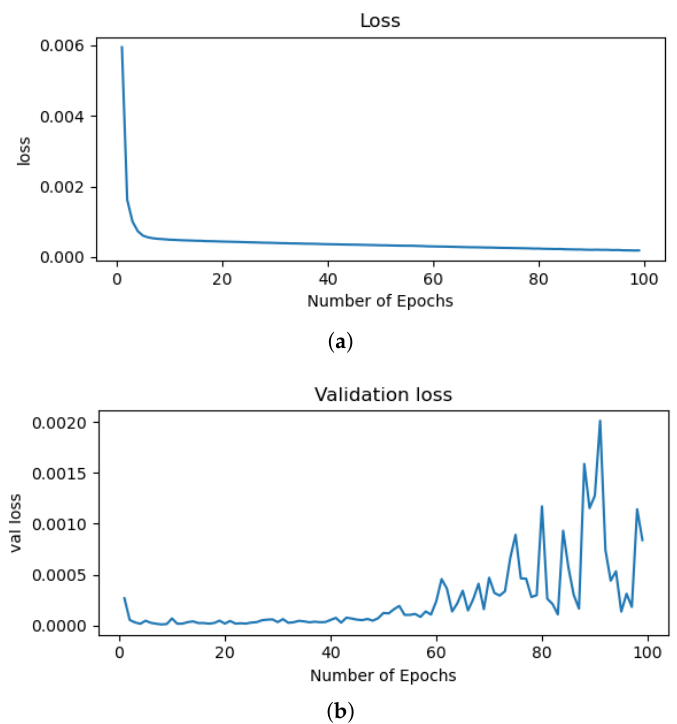
Figure 3. Training progress over training ( a ) and validation ( b )